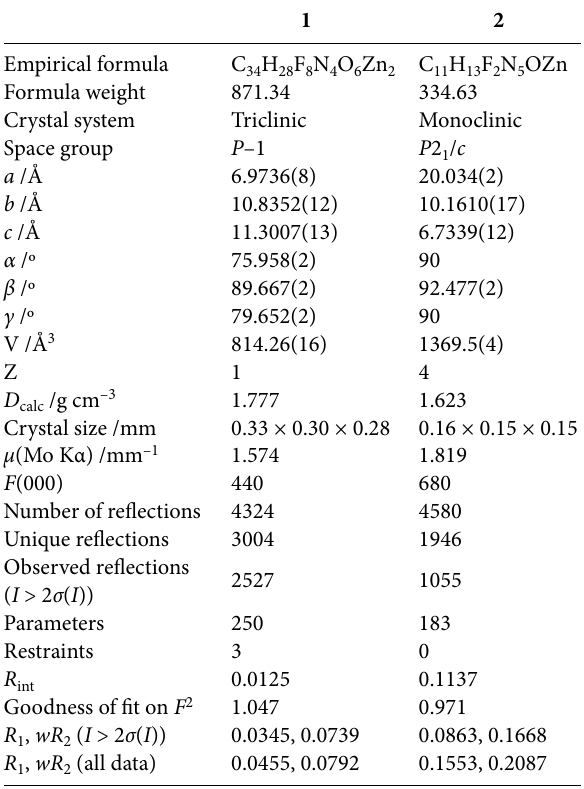
Table 1. Crystallographic data for the complexes